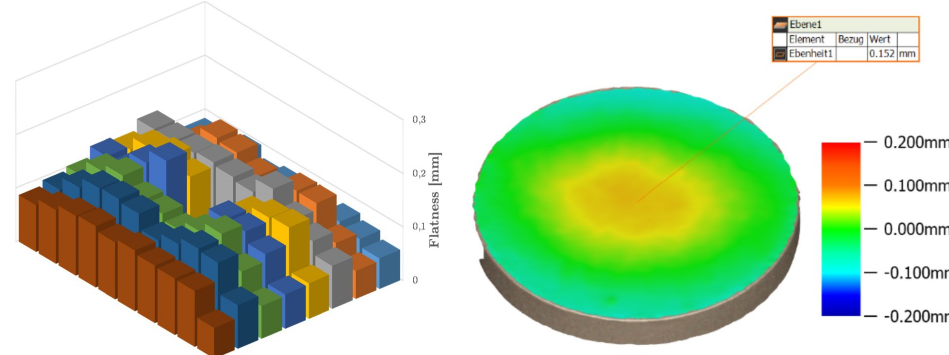
Figure 20. Flatness values distributed over the build area ( left ) and detailed image of the deformation of the components most likely due to the curing process ( right